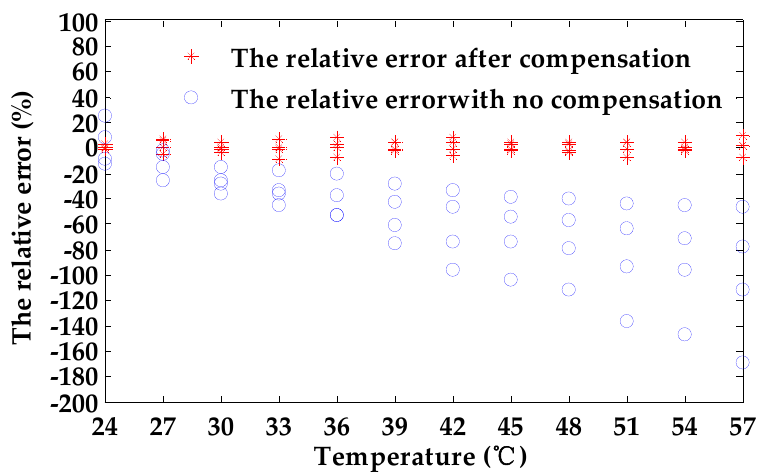
Figure 8. The distribution of the relative error with and without compensation.